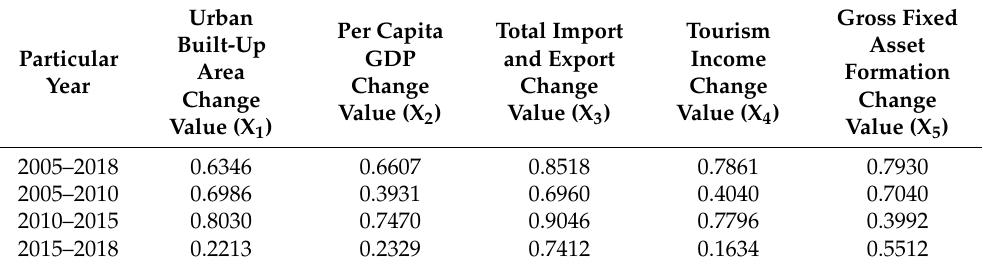
Table 2. Geo-detection results for the drivers.